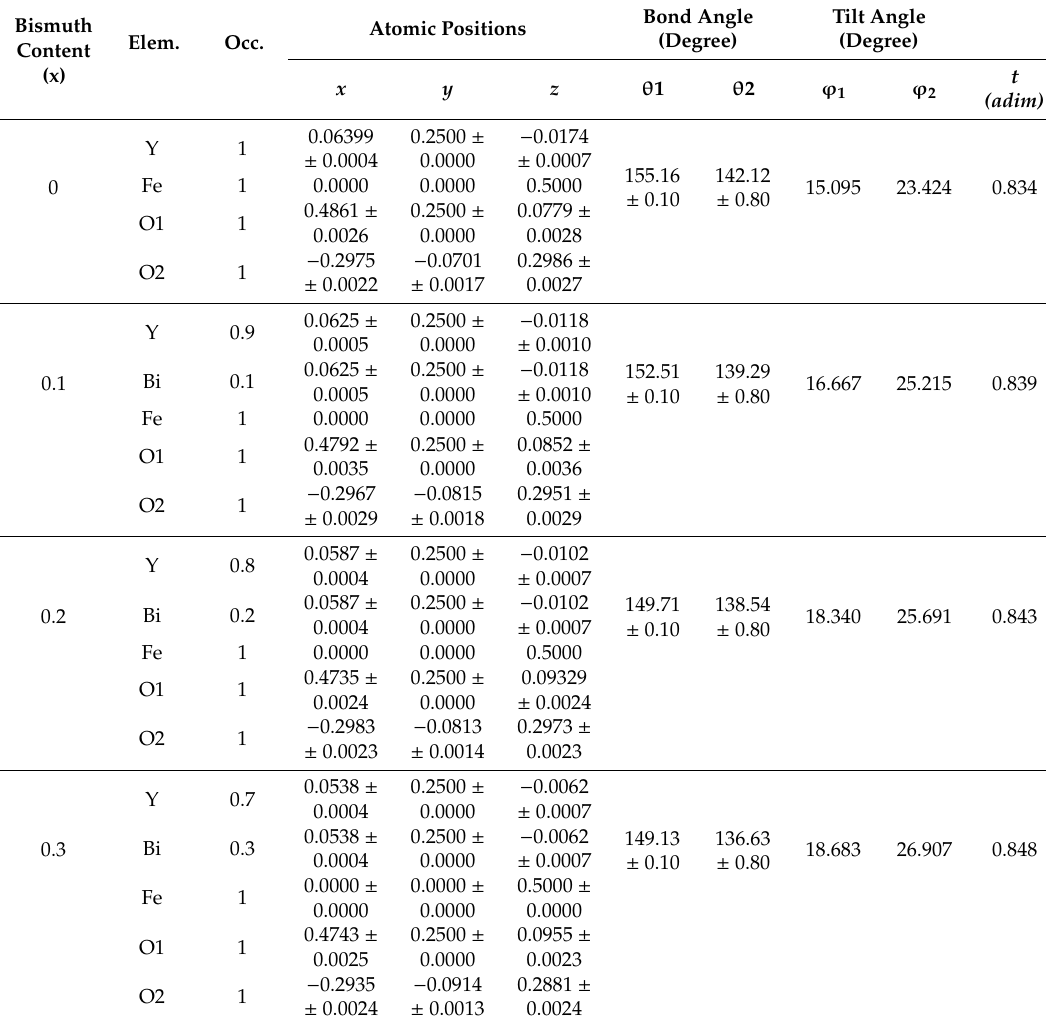
Table 2. Atomic positions (x, y and z), Fe-O-Fe bond angles ( θ 1 and θ 2), tilt angles ( ϕ 1 and ϕ 2 ) and tolerance factor of YFeO 3 phase of samples sintered at 700 ◦